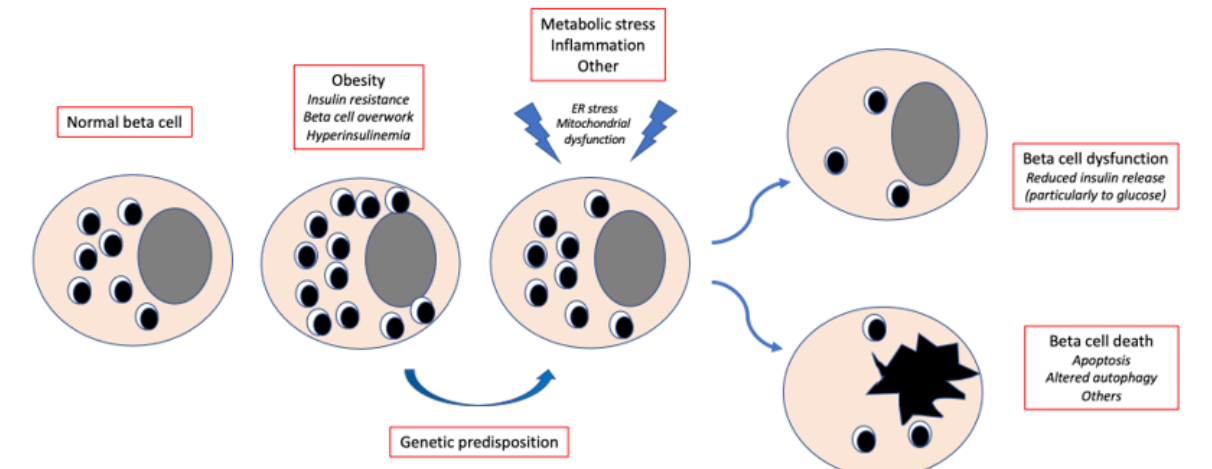
Figure 1. Simplified trajectory of beta cell damage in type 2 diabetes. Obesity and the associated insulin resistance lead to beta cell overwork and the resulting hyperinsulinemia maintains blood glucose levels within the normal range. In case of genetic predisposition, metabolic stress, inflammation and other factors cause alterations in key beta cell organelles, which contributes to beta cell dysfunction and/or death. ER , endoplasmic reticulum.